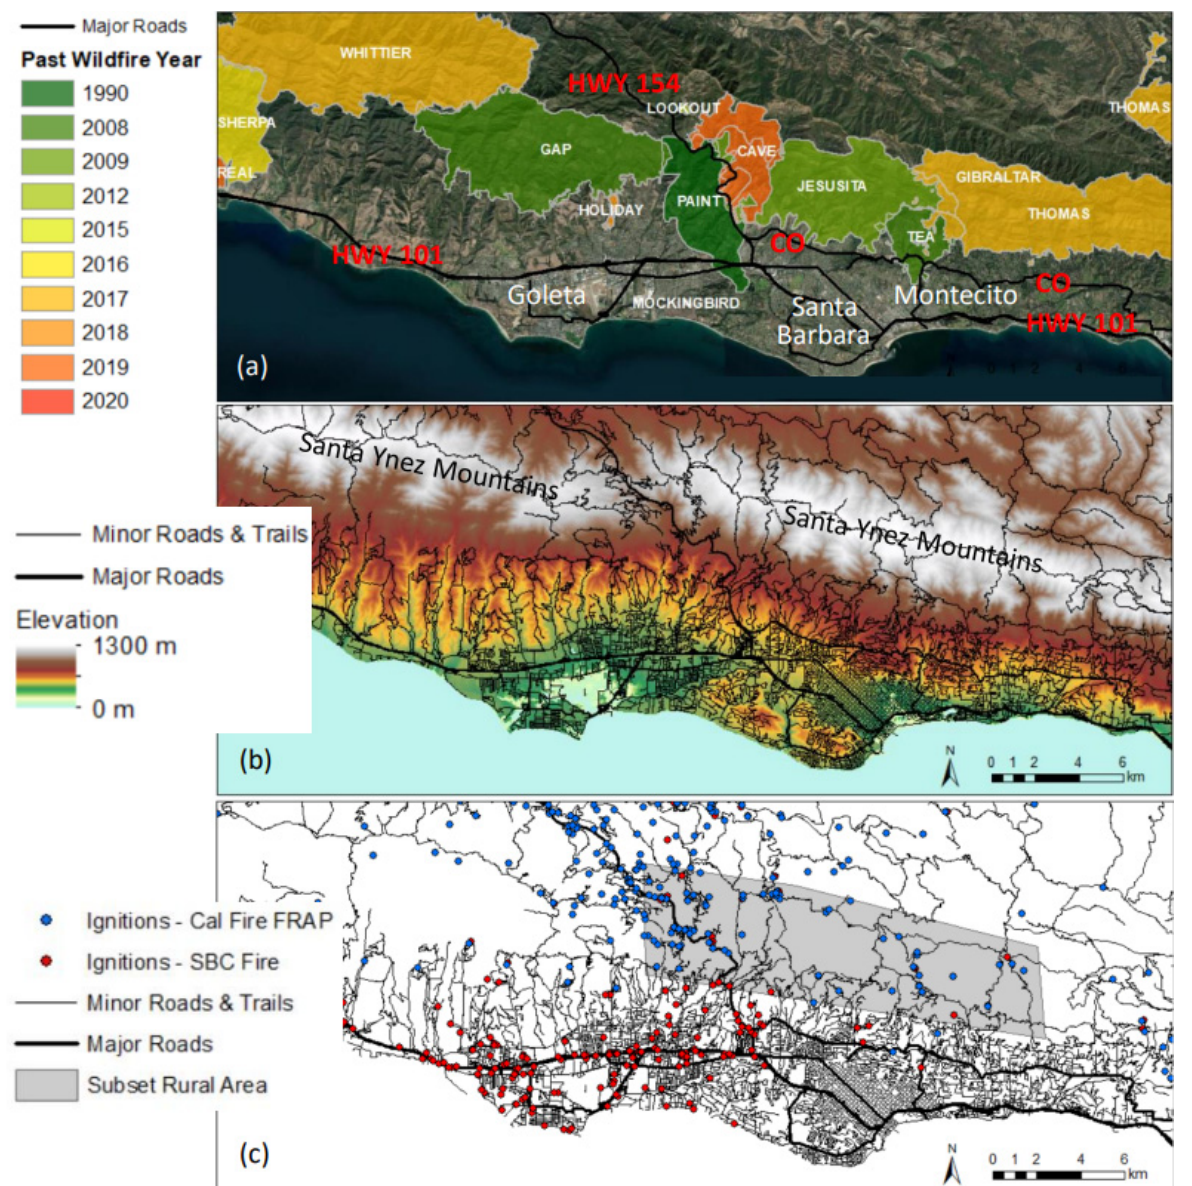
Figure 1. Study area. ( a ) Satellite imagery overlaid with previous wildfires (colored polygons), and major roads (thick, black lines and uppercase red text). The label “CO” stands for “Cathedral Oaks Road”. The names of previous wildfire are smaller and in uppercase text, and cities are in larger, sentence-case text. ( b ) Terrain elevation (colored) and important roads and trails. Major roads are shown as thick lines and minor roads are shown as thinner lines. ( c ) Roads and trails (lines) with previous ignitions overlaid. Color indicates the ignition source database. The area subset for ignition modeling to the north of the cities is shaded gray. A reference map showing the location of Santa Barbara and this coastal subset can be found in Figure A1.